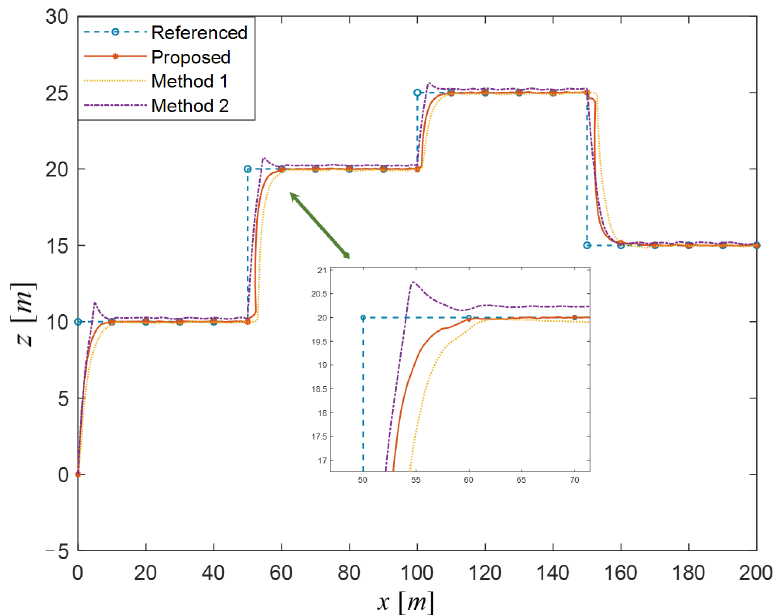
Figure 12. The different methods under the influence of